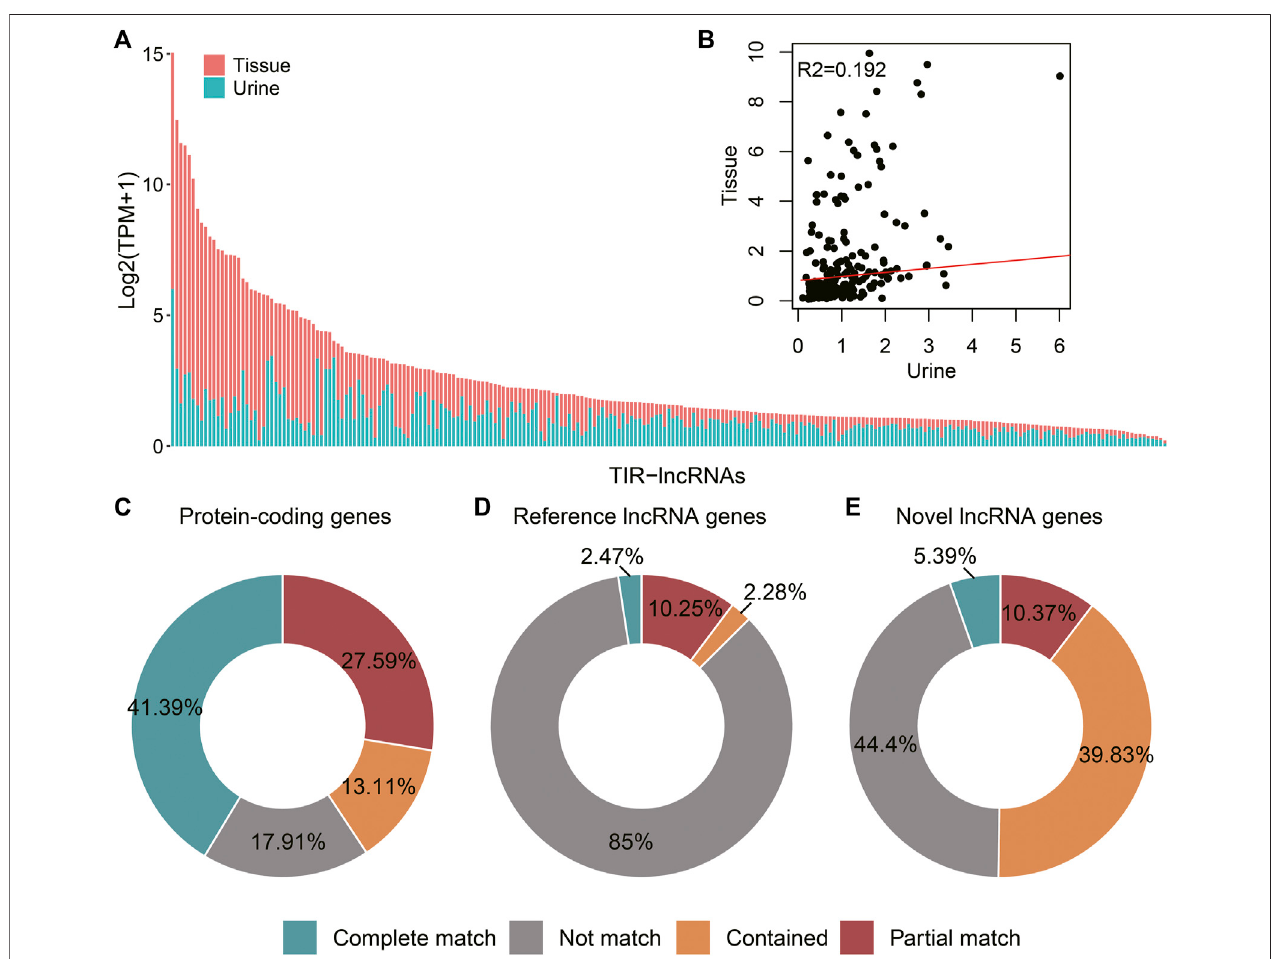
FIGURE6| AssessmentoftumorTIR-lncRNAsreleasingintotheurineinRCC. (A) Barplotsshowedtheexpressionlevel(log2transformedTPM)ofTIR-lncRNAsin tissue samples and urine samples. (B) Scatter plots showed the correlation of TIR-lncRNAs between tissue samples and urine samples. (C) The statistics of assembled urinary transcripts matched to GENCODE v38 genes annotation. (D) The statistics of assembled urinary transcripts matched to RefLncRNA genes annotation. (E) The statistics of assembled urinary transcripts matched to 241 TIR-lncRNAs annotation.